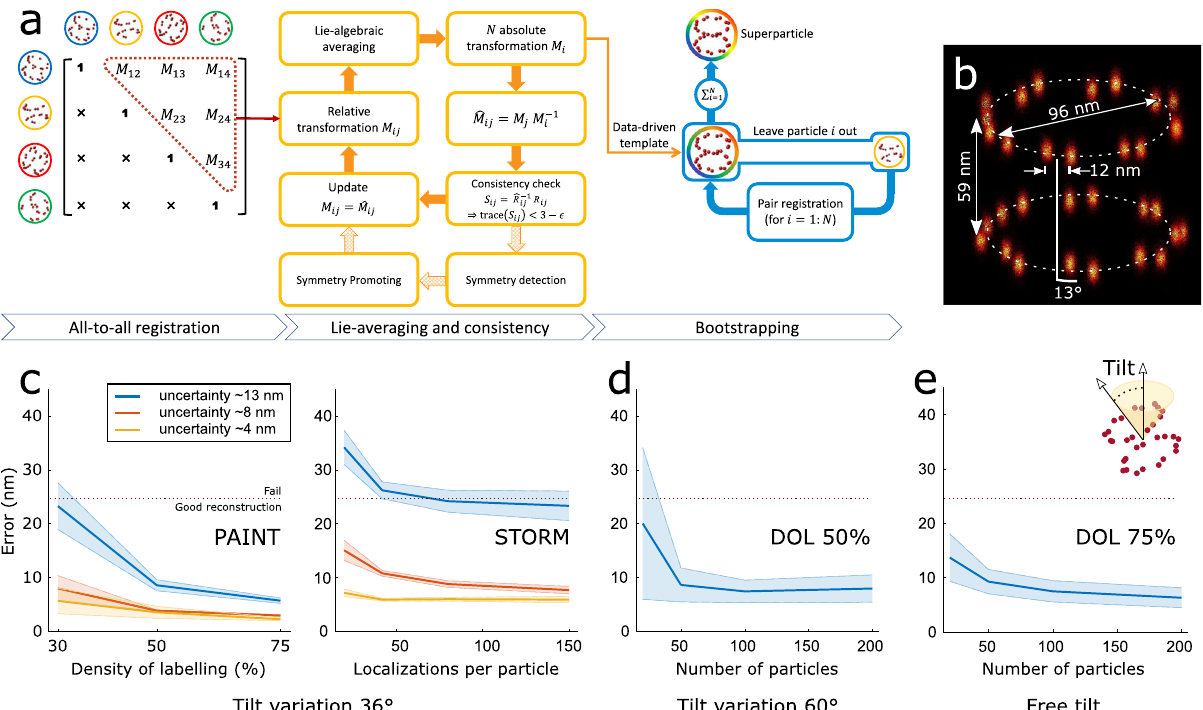
Fig. 1 The 3D SMLM particle fusion pipeline and results of the simulation study. a Pair registration of all segmented particles results in relative transformations M ij (translations t ij and rotations R ij ). The redundant information in the all-to-all registration matrix is utilized for improving the registration errors by means of Lie-algebraic averaging, which results in M i absolute transformations. The relative transformations are recomputed as M j M i − 1 . From them, a consistency check (based on only rotations R ij ) is applied via a threshold ε on the rotation error to remove outlier registrations M ij from the all-to-all matrix. After two iterations, this results in a data-driven template. Additionally, the rotation error residuals that are encoded in the histogram of S ij can be used to infer symmetry group(s) of the particle structure and to subsequently impose symmetry on the data. Finally, fi ve rounds of bootstrapping are applied to improve the fi nal reconstruction by registering every particle to the derived template. b Ground-truth fusion of 100 simulated NPCs indicating the height, radius, the angular shift between the cytoplasmic and nuclear rings in the same NPC. c Registration error for simulated PAINT and STORM data for different degree of labeling (DOL), mean localization uncertainties ( σ = 4, 8, and 13 nm) and number of localizations per particle. Successful super- particle reconstruction is possible below a registration error of 25 nm. d Registration error of simulated PAINT data with 50% DOL and tilt angle of 60 degrees at different number of particles per dataset. e Registration error of simulated PAINT data with 75% DOL and arbitrary pose at different number of particles per dataset. Solid lines indicate the mean and shaded area show the standard error of the mean ( n =